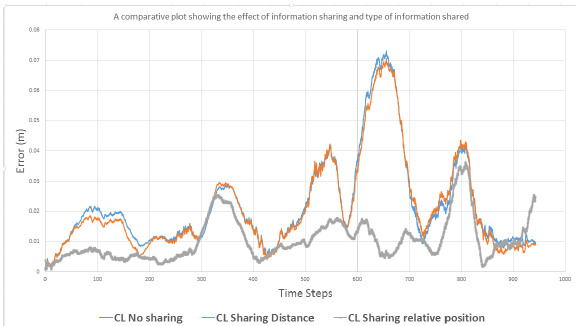
Figure 2: Error comparison for the position of a node for the case with and without information (relative range and relative position) sharing. The relative range accuracy in this case is as- sumed to be 2cm while relative position accuracy is about 5 cm and GNSS signal was available to both the nodes throughout the operation.